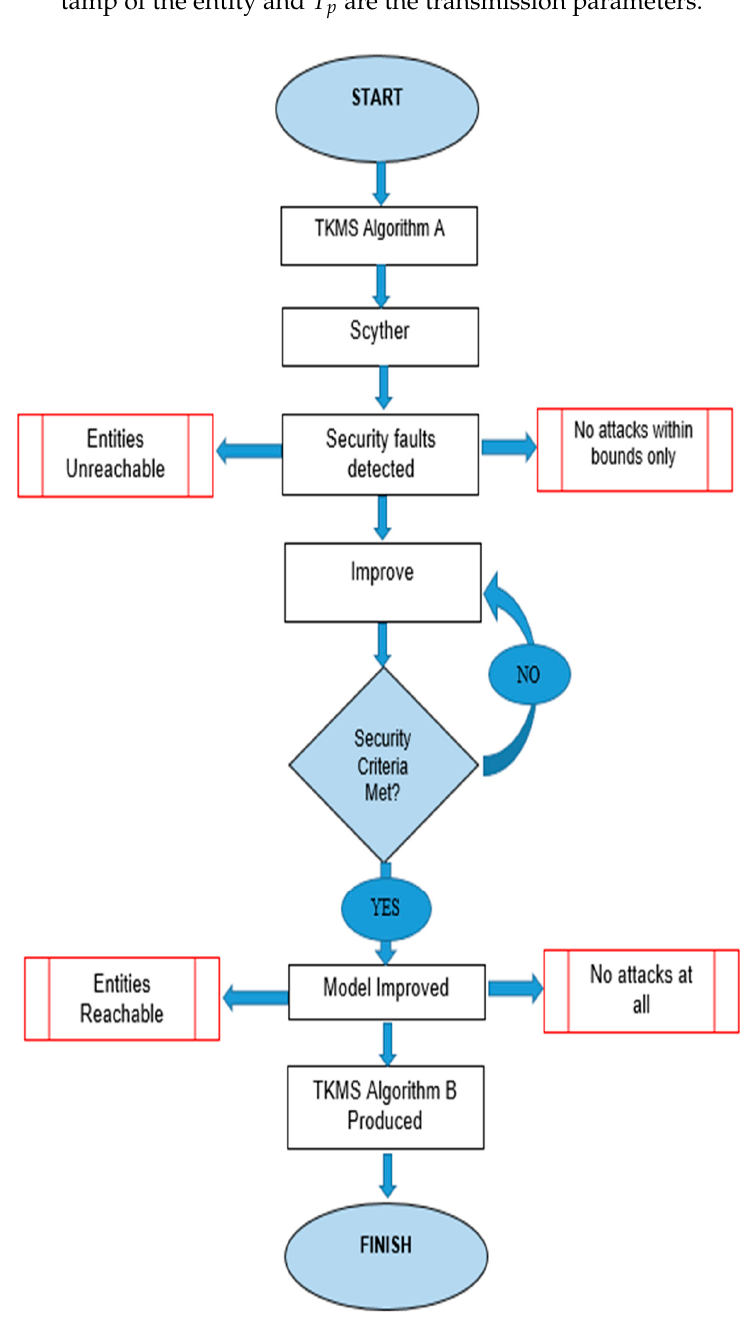
Figure 2. Key generation and distribution process in TKMS.